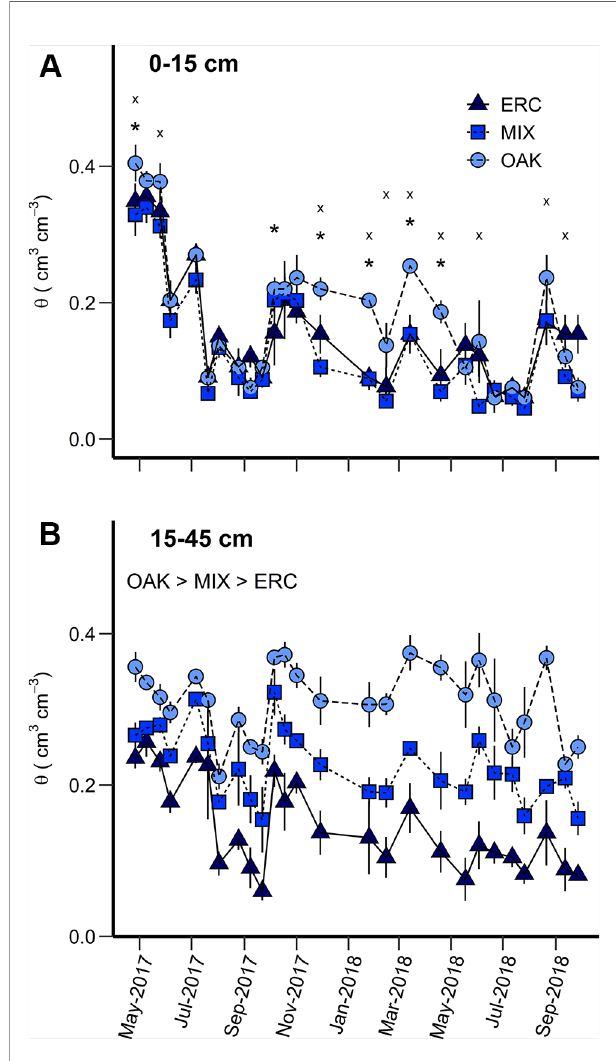
FIGURE 2 | Volumetric soil water content ( q ) for the (A) 0 – 15 cm and (B) 15 – 45 cm soil layers for the oak stand (OAK), mixed stand (MIX), and eastern redcedar stand (ERC) between April 2017 and September 2018. For the 0 – 15 cm layer, asterisks (*) indicates signi fi cant differences (p < 0.05) between OAK and ERC, and the letter “ × “ indicates signi fi cant differences (p < 0.05) between OAK and MIX. For the 15 – 45 cm layer, mean daily q was signi fi cantly different among stands (OAK stand > MIX stand > ERC stand) (p < 0.05). Vertical bars represent standard error of measurements at each date (not shown when smaller than the symbol